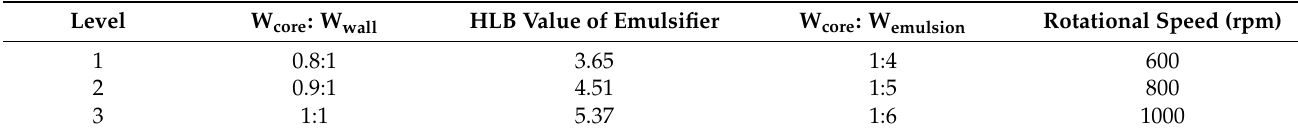
Table 2. Orthogonal test factors and levels.